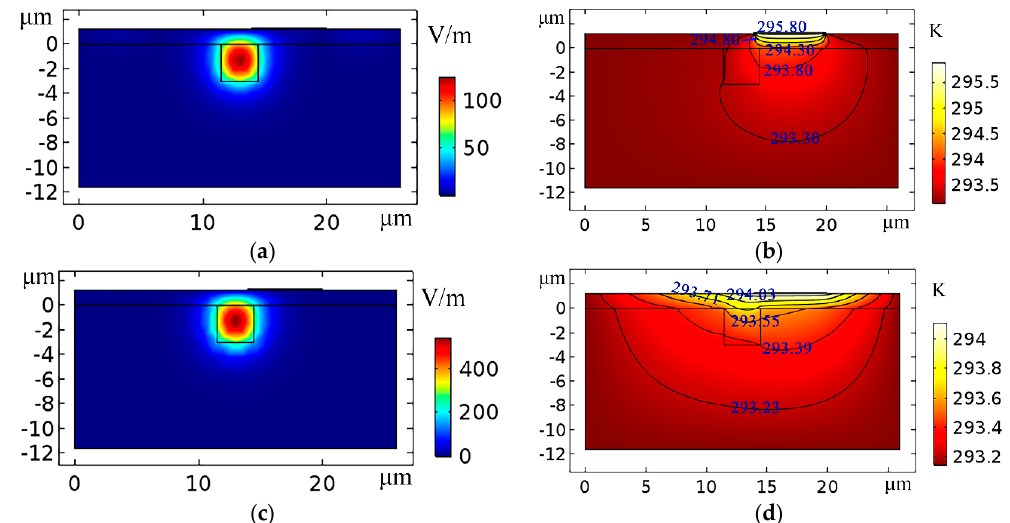
Figure 3. Inverted ridge TO switch with side electrode structure. ( a ) Optical field distribution in the heating region without a graphene film; ( b ) thermal field distribution in the heating region without a graphene film; ( c ) optical field distribution in the heating region for a graphene TO switch; ( d ) thermal field distribution in the heating region for a graphene TO switch.